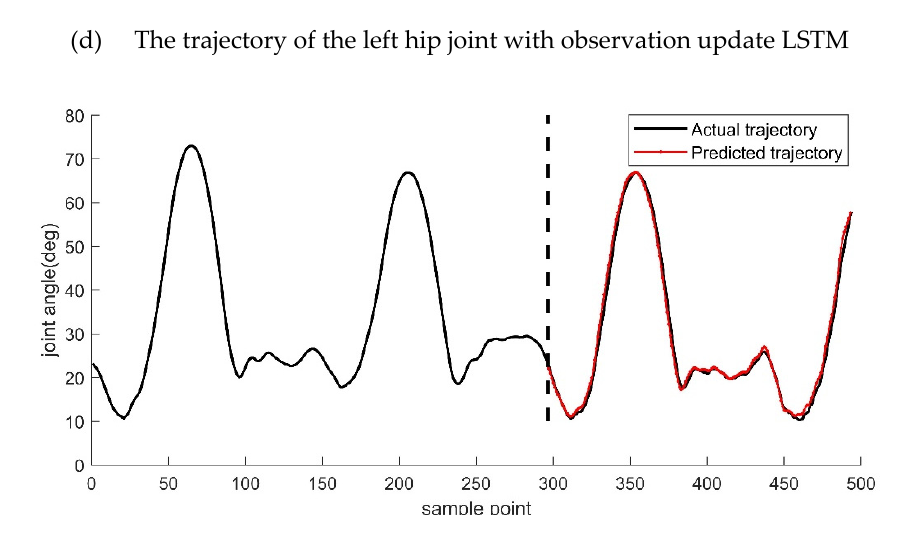
(e) The trajectory of the left knee joint with observation update LSTM Figure 4. Cont